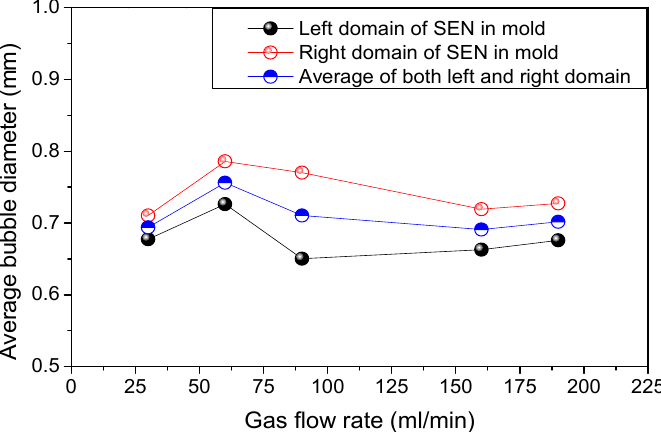
Figure 14. Effect of gas flow rate on the average diameter of bubbles.